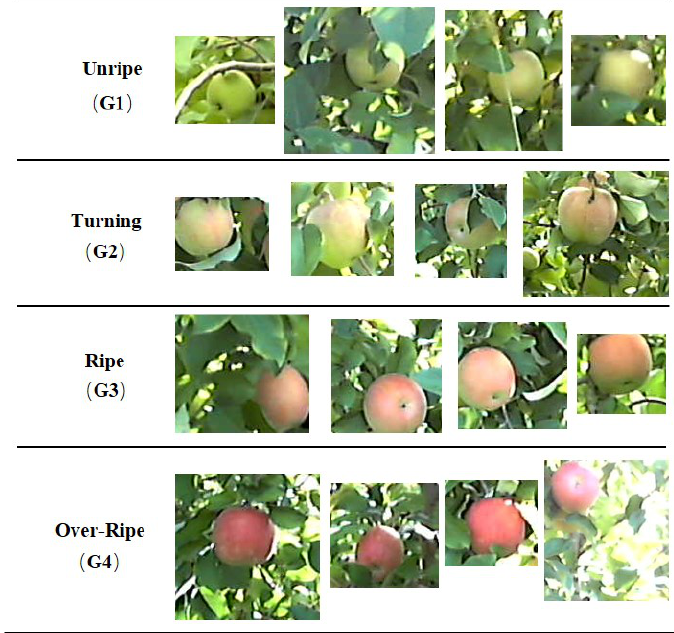
Figure 3. The partial samples of our proposed Fuji apple maturity